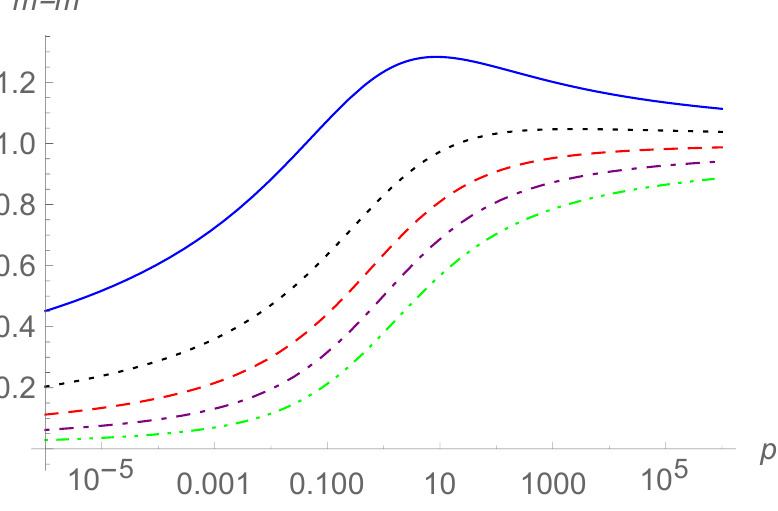
Figure 10. The mass contribution ˆ m − m versus p for η = 1 and for ω = 0.2 (solid line), 0.5 (dotted line), 1 (dashed line), 2 (dot-dashed line), and 5 (dot-dot-dashed line). By using the equivalent damping ˆ c and the equivalent mass ˆ m in Equations (43) and (44), the system response x ( t ) , the frequency–amplitude response γ ( ω ) , and the frequency-phase response ϕ ( ω ) can be calculated from Equations (35)–(37). We take m = k = 1, c = 0.5, and η = 0.5 and 5 to examine the frequency–amplitude response and frequency-phase response for different values of the parameter p . In Figures 11 and 12, the frequency–amplitude curves are shown for η = 0.5 and 5, respectively. In Figures 13 and 14, the frequency-phase curves are displayed for η = 0.5 and 5,